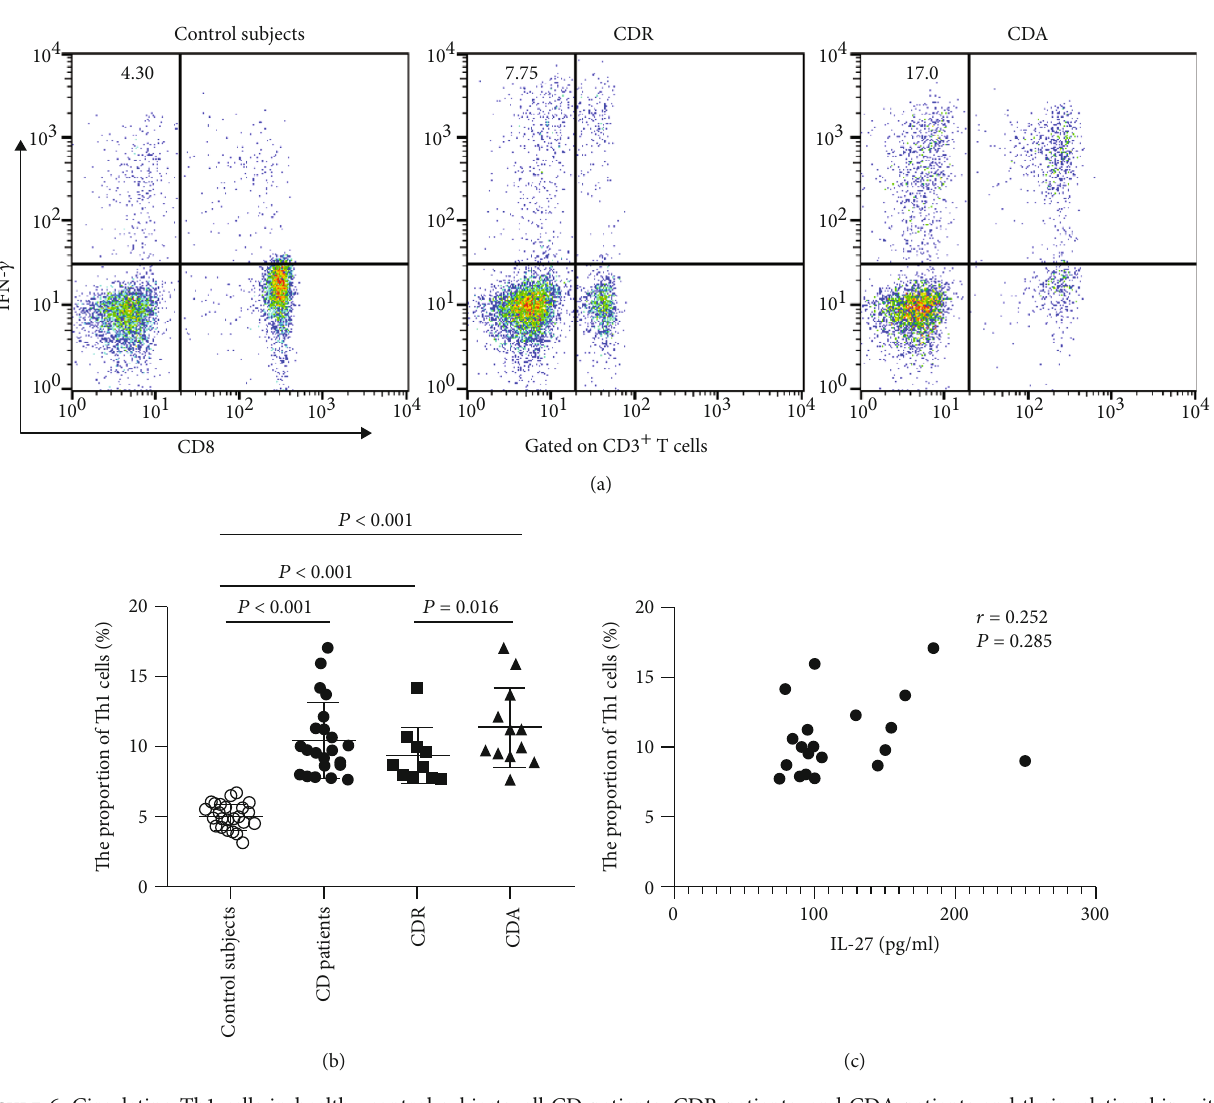
Figure 6: Circulating Th1 cells in healthy control subjects, all CD patients, CDR patients, and CDA patients and their relationship with serum IL-27 levels. (a) Representative dot plots of IFN- γ expression in peripheral CD4 + T cells (gate CD3 + CD8 - T cells) of HC subjects, all CD patients, CDR, and CDA. (b) Scatter plot showing the proportion of circulating Th1 cells and the results of statistical analysis by using the nonparametric Mann – Whitney rank test. (c) Correlation of serum IL-27 levels with circulating Th1 cells. Spearman ’ s rank correlation test was used to assess the correlations. CD: Crohn ’ s disease; CDR: CD patients in remission; CDA: CD patients in